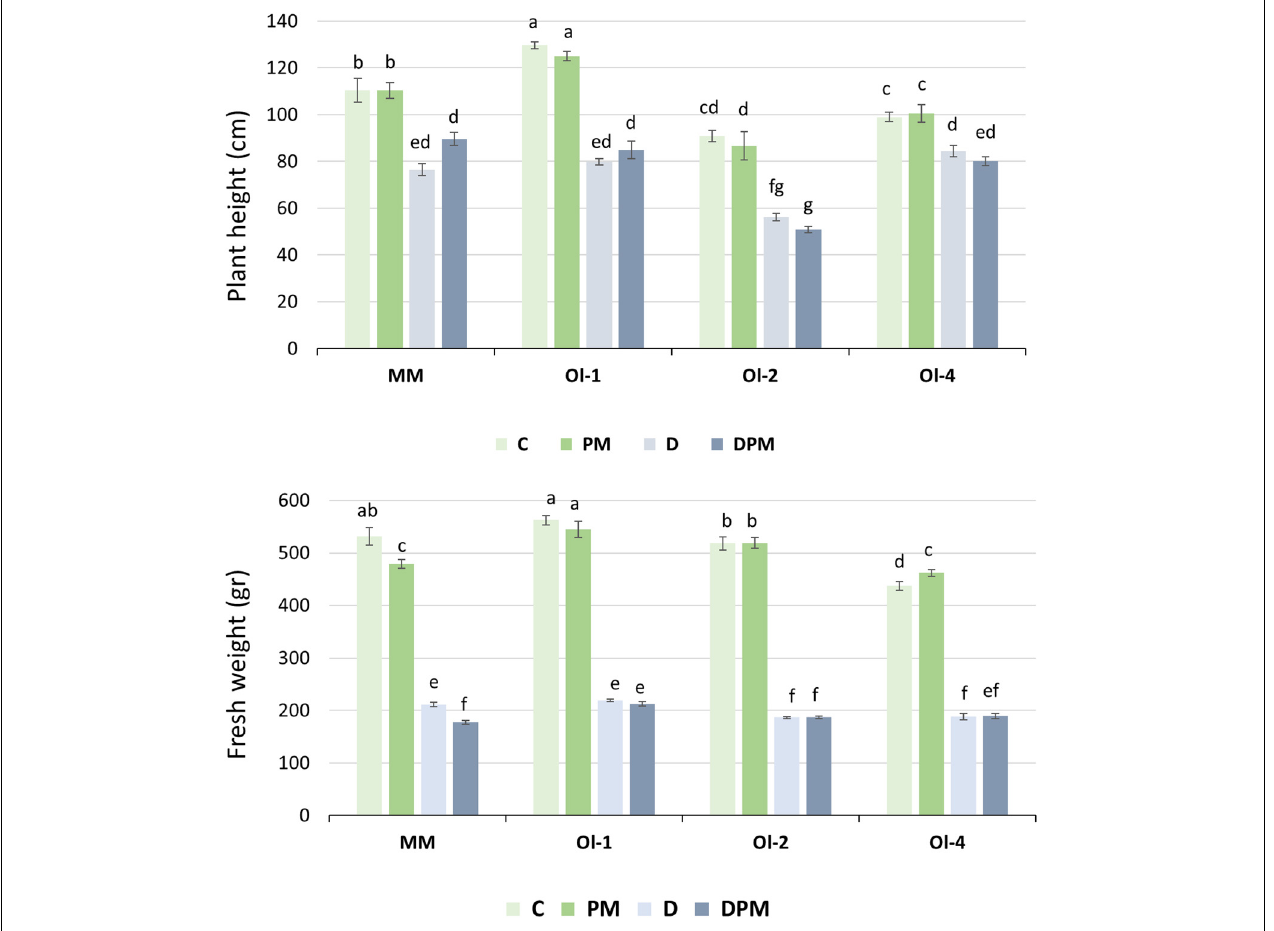
FIGURE 3 | Plant height and shoot fresh weight under control conditions (C), moderate drought stress (D), PM infection (PM), combined D and PM (DPM). Data represents means ± SEM of four biological replicates. Different letters indicate significant differences ( P < 0.05) compared to MM under control conditions.